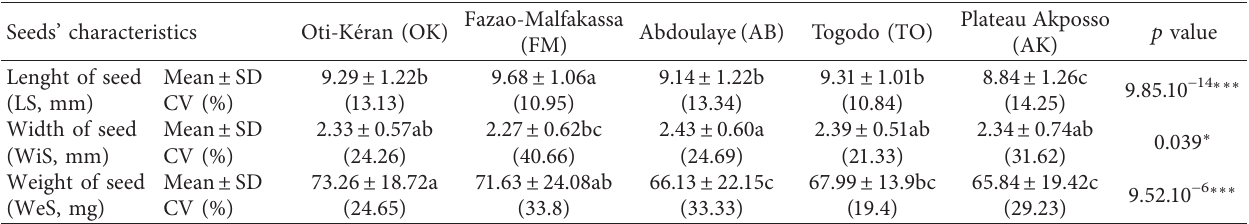
Table 12: Mean values and coefficients of variation (CV in percentage) of P. erinaceus seeds’ variables. Seeds’